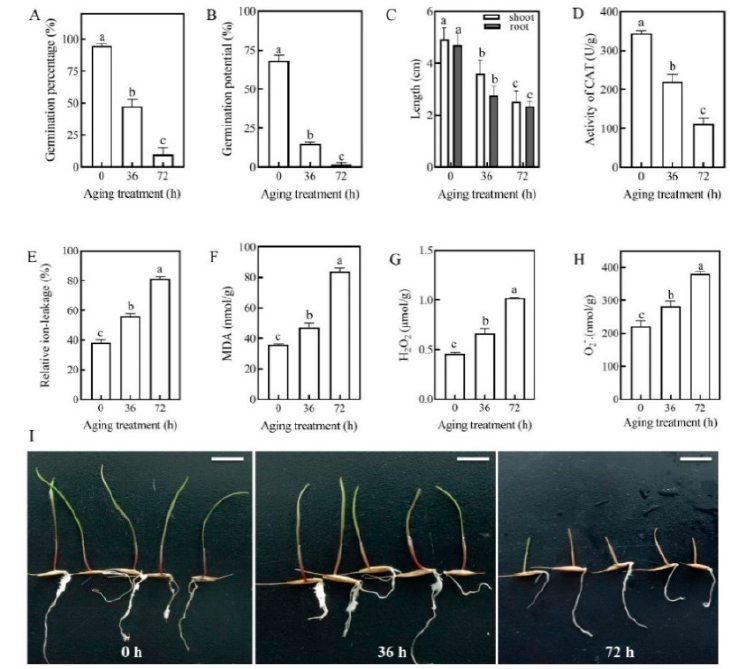
Figure 1. The seed germination characters and physio-biochemical status of E. sibiricus seeds with different aging treatments. ( A ) Germination percentage of E. sibiricus were calculated every day until 14 days; ( B ) Germination vigor in different aging time; ( C ) comparison of shoot length and root length in response to different aging treatments 14 days after germination; ( D ) the activity of catalase (CAT); ( E ) Relative ion-leakage (RIL); ( F ) malondialdehyde (MDA) content; ( G ) H 2 O 2 content ; ( H ) O (cid:2870)(cid:2879) content; ( I ) Phenotypes of E. sibiricus seeds applied by aging treatments (Bar = 1 cm). The different lowercase letters indicate significant differences at p < 0.05 and all treatments were conducted with three biological replicates.